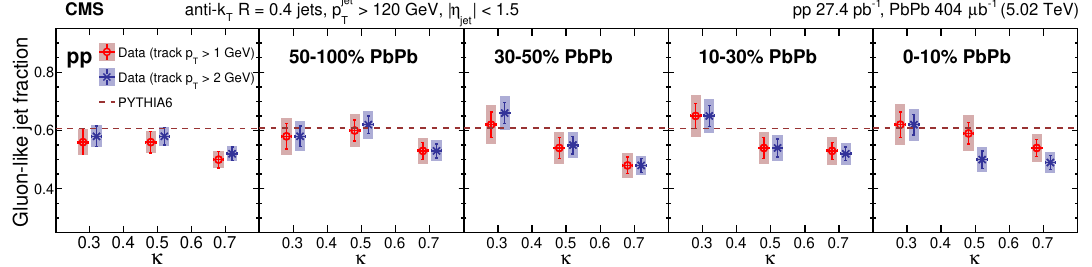
Figure 4 . Fitting results for the extraction of gluon-like jet fractions in pp and PbPb data shown for p -weighting factor (cid:20) values of 0.3, 0.5, and 0.7 in di(cid:11)erent event centrality bins in PbPb. The T markers for track p > 1 and > 2 GeV have been separated horizontally for clarity. The systematic T and statistical uncertainties are represented by the shaded regions and vertical bars,